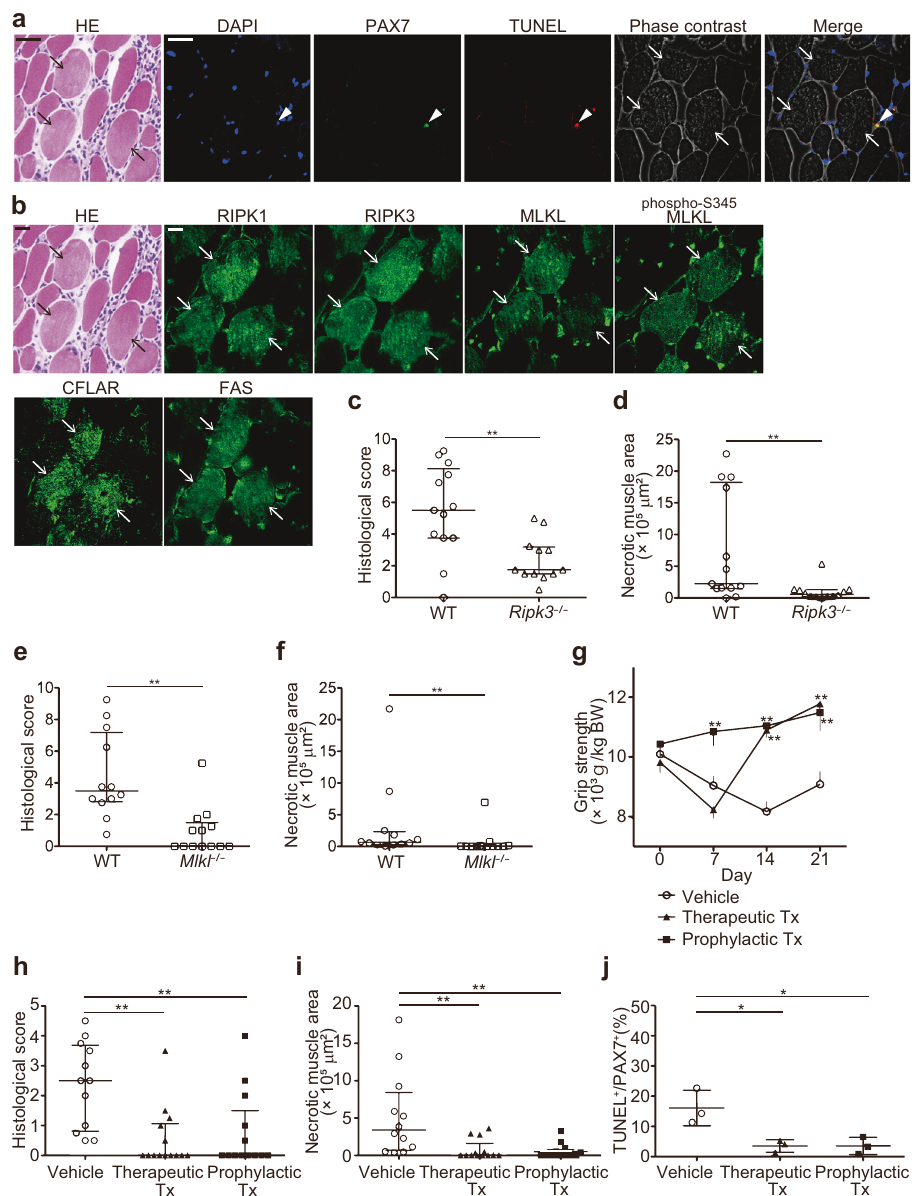
Fig. 5 The involvement of necroptosis in the muscle in fl ammation and muscle weakness in CIM. a HE, immuno fl uorescence staining against PAX7 (green), and the TUNEL staining (red). Nuclei were counterstained with DAPI (blue). The arrowhead indicates PAX7 positive TUNEL positive satellite cell. b HE and immuno fl uorescence staining (green) for the expression of RIPK1, RIPK3, MLKL, phosphorylated-S345 (phospho-S345) MLKL, CFLAR, and FAS in the muscle specimens of CIM mice. a , b The arrows indicate the dying muscle fi bers. Scale bars indicate 20 μ m. Each histological examination was performed three times and the representative images are shown. c , d The histological scores ( c ) of the severity of myositis and the area of necrotic muscle fi bers ( d ) in wild-type (WT, n = 13) or Ripk3 − / − ( n = 12) mice on day 14 of CIM. e , f The histological scores ( e ) and the area of necrotic muscle fi bers ( f ) in WT ( n = 12) or MLKL − / − ( n = 13) mice on day 14 of CIM. c – f Data are presented as median ± interquartile range. Mann – Whitney U test. ** p < 0.01. g The grip strength of CIM mice treated with Nec1s or the vehicle ( n = 12). The treatment was started immediately after the immunization in the prophylactic group (Prophylactic Tx, n = 13), or from day 7 in the therapeutic group (Therapeutic Tx, n = 14). BW; Body weight of the mice. Data are presented as mean ± SD. Two-way ANOVA test, followed by Dunnett ’ s multiple comparison test. ** p < 0.01. h , i The histological scores ( h ) and the area of necrotic muscle fi bers ( i ) on day 21 of CIM. Vehicle; n = 12, Therapeutic Tx; n = 14, Prophylactic Tx; n = 13. Data are presented as median ± interquartile range. Kruskal – Wallis test, followed by Dunn ’ s test. ** p < 0.01. j Proportion of TUNEL + cells out of PAX7 + cells in the muscles of CIM on day 21. Vehicle; n = 3, Therapeutic Tx; n = 3, Prophylactic Tx; n = 3. Data are presented as mean ± SD. One-way ANOVA test, followed by Dunnett ’ s test. * p < 0.05. c – j Data represent two independent